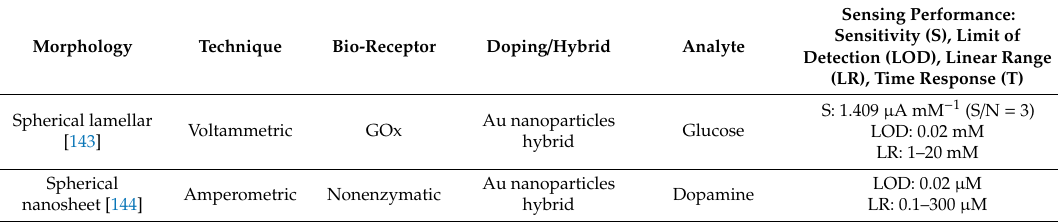
Table 4. Different techniques of 3-D ZnO-based electrochemical biosensors for various analyte detections, since 2014.